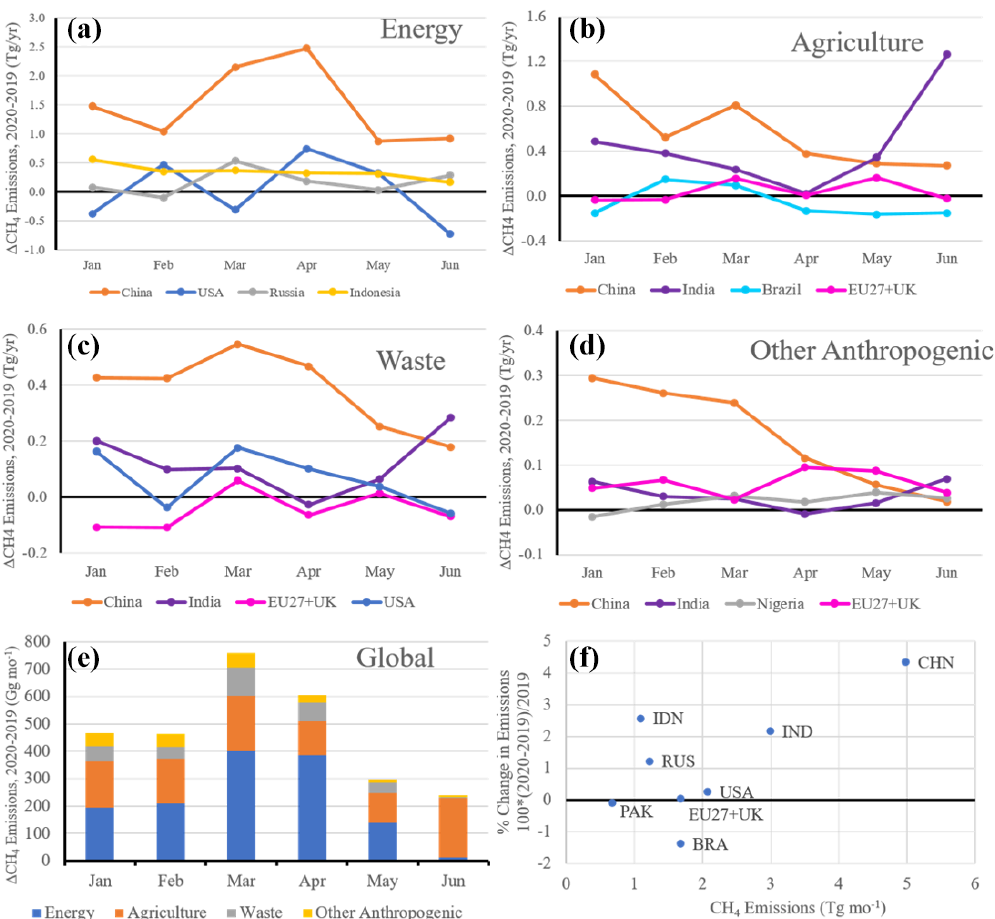
Figure 11. Estimated national or regional average CH 4 emission change between 2020 and 2019 for January to June, derived using an IFS inversion for the largest emitters for (a) energy, (b) agriculture, (c) waste and (d) other anthropogenic sources. (e) Global change in sector-specific monthly CH 4 emissions for the same period. (f) National or regional change in total anthropogenic CH 4 emissions for the same